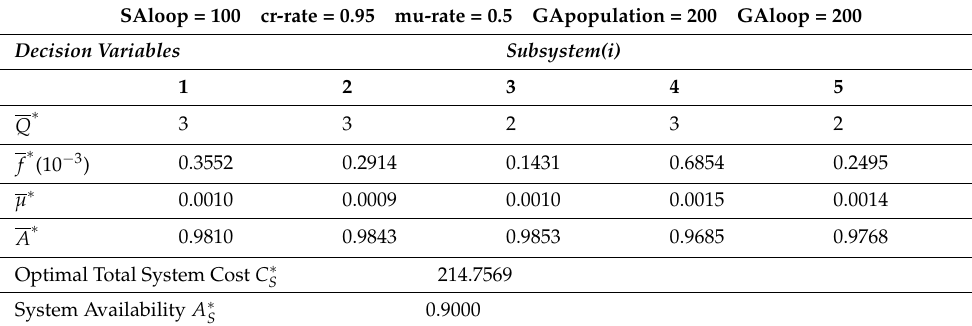
Table 20. Optimal Solutions obtained by SA–MGA for the parallel-series